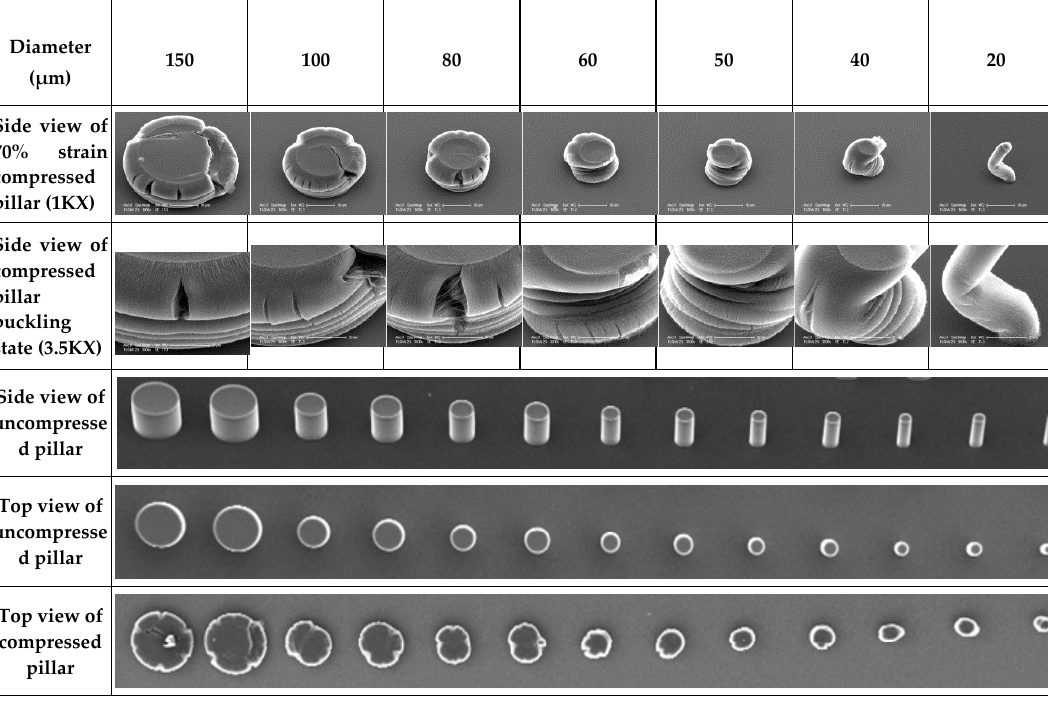
Figure 5. SEM images of pristine CNT pillars after 70% compressed strain of various